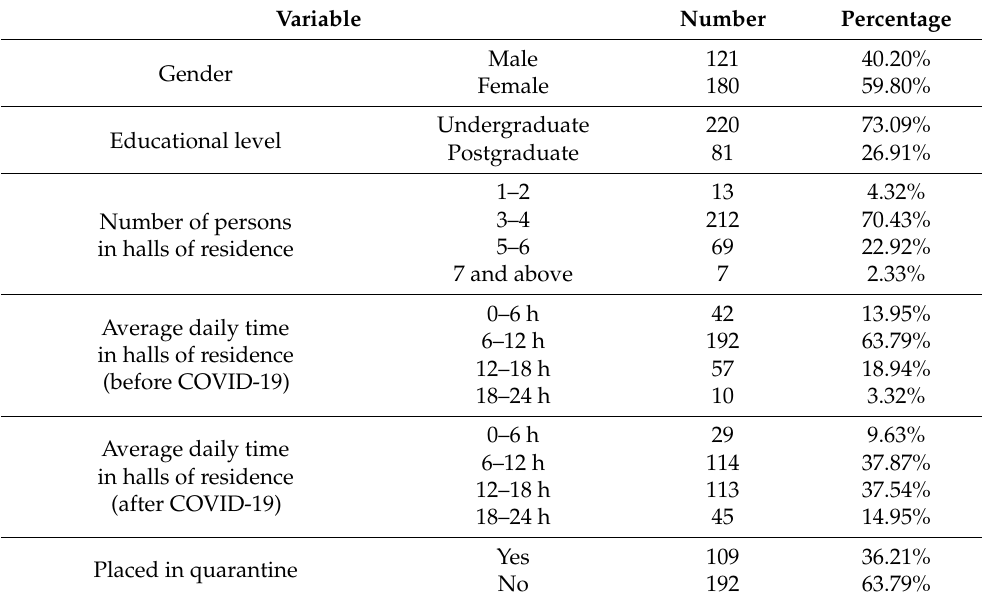
Table 2. Profile of survey respondents ( n = 301).